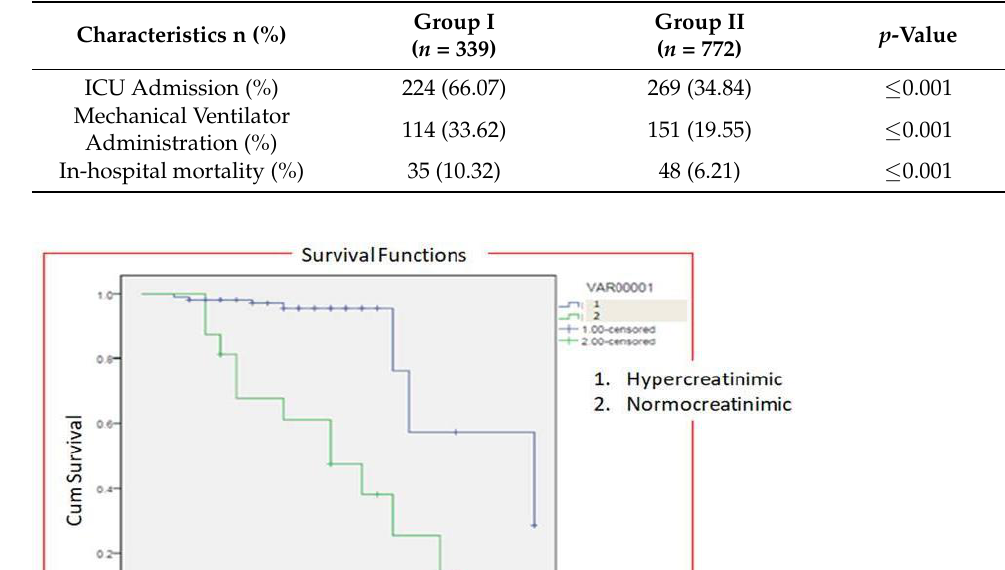
Figure 8. Risk-adjusted Cox regression analysis curves through 25 days for patients with COVID-19 stratified by normocreatinemia (Group-I) and hypercreatinemia (Group-2). Table 3. Clinical outcomes of study population according to creatinine levels.